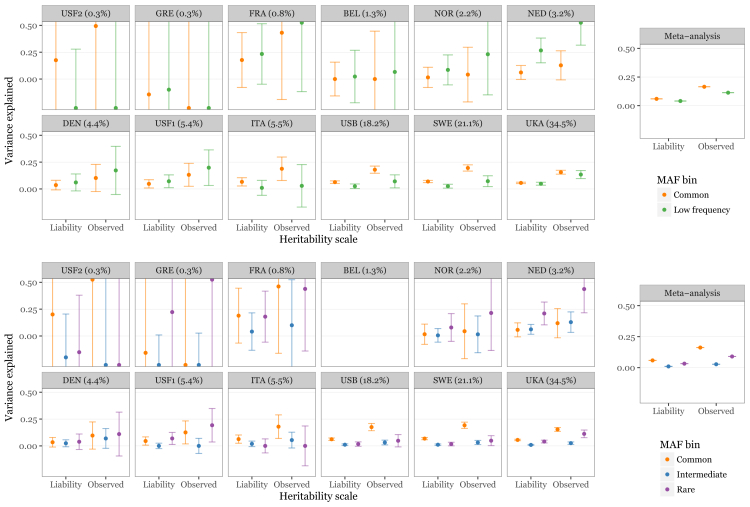
Rare Variants Explain a Substantial Portion of Multiple Sclerosis HeritabilityWe estimated the MS risk heritability explained by common variants (MAF > 5%) and low-frequency non-synonymous coding variation (MAF < 5%) in each of 13 cohorts genotyped on the exome chip using genome-wide complex trait analysis (GCTA; top). By meta-analyzing these estimates across cohorts, we found that low-frequency variants explain 11.34% of heritability on the observed scale, which corresponds to 4.1% on the liability scale (right top). After dividing the low-frequency variants into intermediate (5% > MAF > 1%) and rare (MAF < 1%; bottom), we found that the latter alone explains 9.0% heritability on the observed scale (3.2% on the liability scale; bottom right). Meta-analysis confidence intervals are small and visually occluded by the mean estimate plot characters. Cohorts (abbreviations as in Table S1) are ordered by sample size, with the percentage of the overall sample size shown in each subplot title. We could not obtain estimates for either model for our Finnish cohort (see STAR Methods; not shown), or for the three-component model for our Belgian cohort (bottom, top row, fourth from left). Both cohorts are small, which may explain the failure to converge.